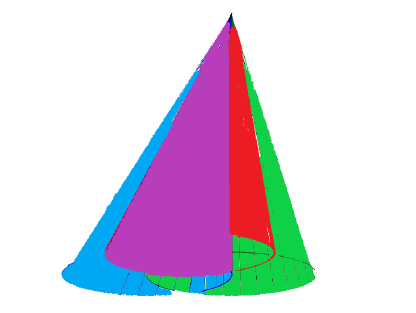
Figure 7. In purple it appears the bounded area corresponding to a relative class in H 2 ( S 3 , B ) , where B denotes the underlying Borromean